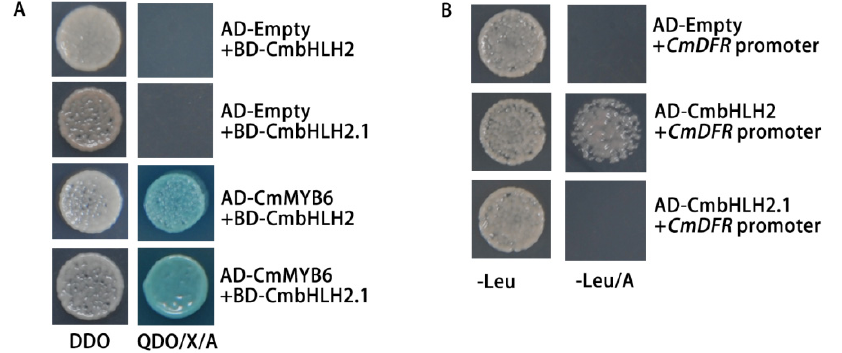
Figure 6. Protein–protein and protein–DNA interaction in yeast. ( A ) Protein–protein interaction between CmbHLHs and CmMYB6. ( B ) Interaction of CmbHLH2 and CmbHLH2.1 with the CmDFR promoter. DDO, SD/ − Leu/ − Trp; QDO, SD/ − Ade/ − His/ − Leu/ − Trp; X, X- α -Gal; A, aureobasidin A; AD, GAL4 activation domain; BD, GAL4 DNA binding domain.